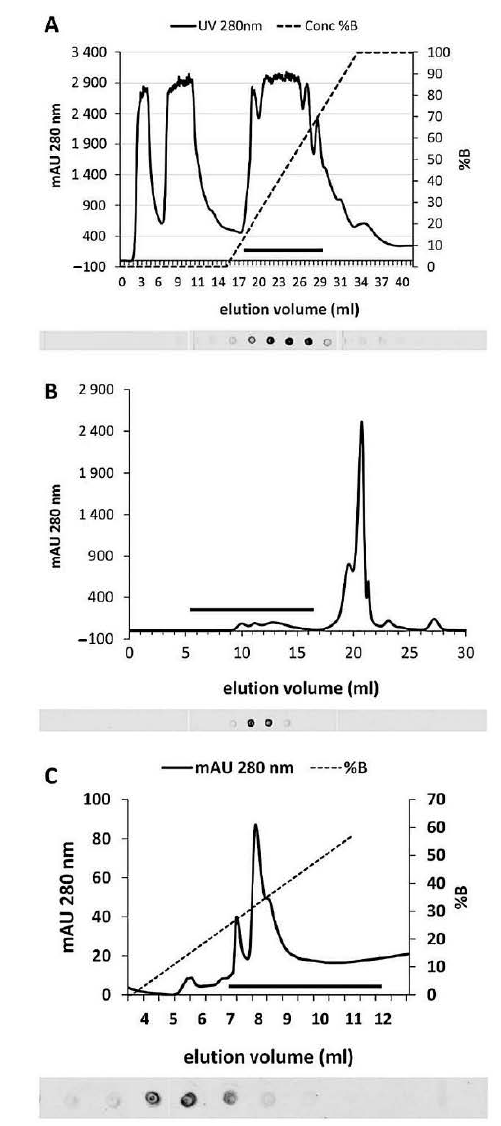
Figure 2. Stages of purification of Sucrose synthase from nettle stems. ( A ) Graph of ion-exchange chromatography on a Resource-Q or HiTrap-Q column. The absorbance profile at 280 nm and the percentage profile of the NaCl gradient (dotted line) used to elute proteins are shown. The black bar at the bottom indicates the fractions whose spot test is shown just below. Spot test analysis highlights the position of Sucrose synthase . ( B ) Elution profile by gel filtration chromatography used as the second step of purification of Sucrose synthase . The graph shows the absorbance at 280 nm. The horizontal bar also corresponds to the spot test shown just below, in which the fractions enriched in Sucrose synthase are highlighted. ( C ) Graph of the third step of purification of Sucrose synthase by anion exchange chromatography on a Mini-Q column. The 280 nm absorbance profile and the percentage profile of the NaCl gradient (dotted line) used to elute the proteins are shown. The horizontal black bar at the bottom corresponds to the spot test shown just below where the fractions containing Sucrose synthase are